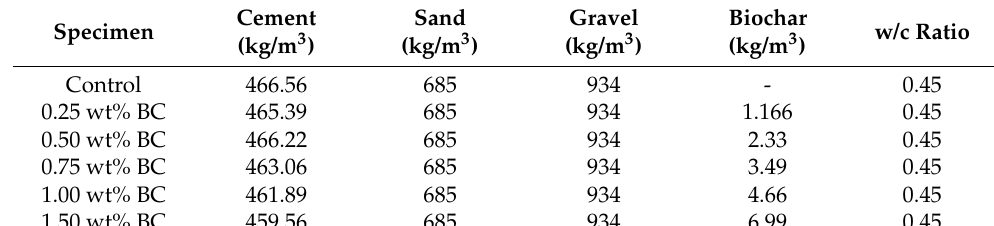
Table 1. Mix design composition of Biochar-concrete specimen.